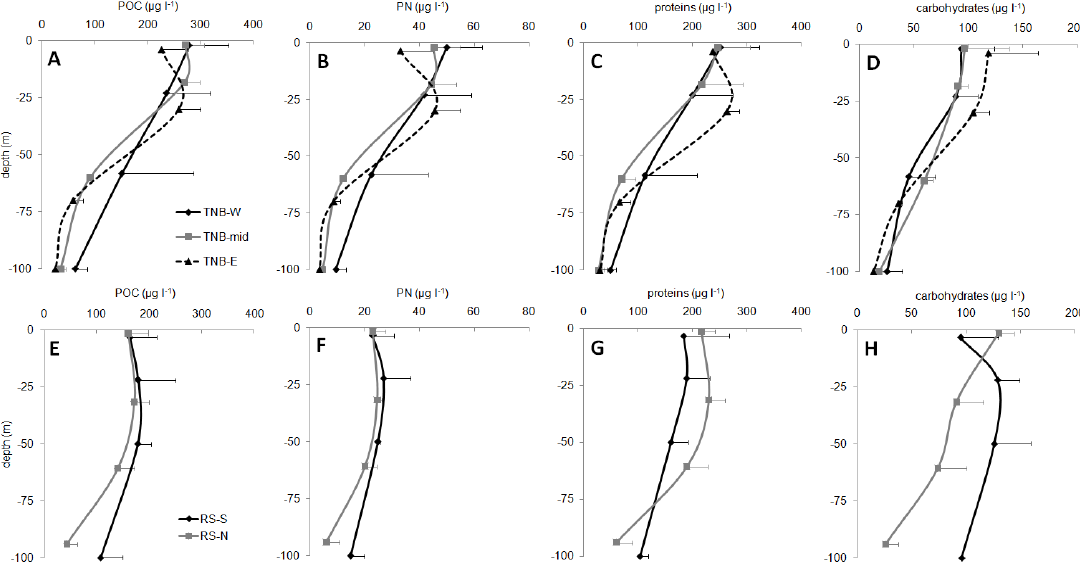
Figure 3. Concentrations of the POM (µg L −1 ) in the coastal TNB macro-area (upper panels A – D ) and in the RS offshore macro-area (lower panels E – H ).